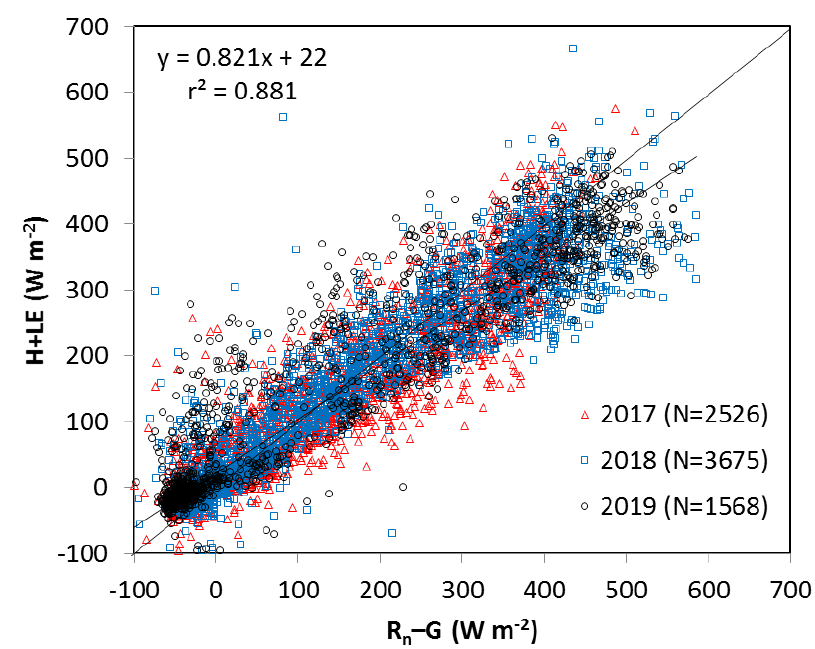
Figure 5. Hourly values of turbulent fluxes (H + LE) versus available energy (R n –G) for the 2017–2019 experimental campaigns. Linear regression parameters for the full dataset, and observation data (N) for each season, are inserted.